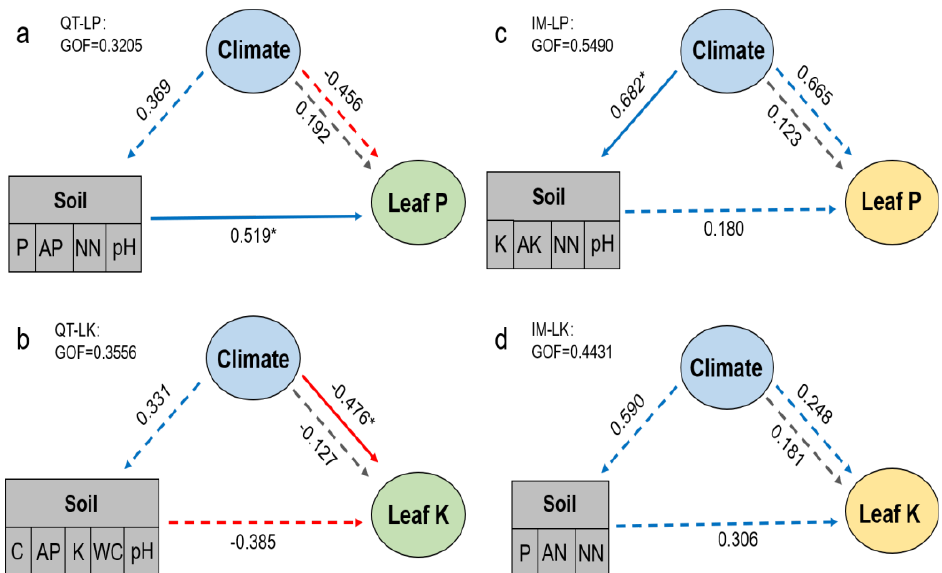
Figure 2. Effects of different soil and climatic variables on the leaf P and K of S. chamaejasme in the Qinghai−Tibet Plateau (QT) and Inner Mongolia Plateau (IM) based on partial least squares path modeling. The blue arrows represent positive pathways, the red arrows indicate negative pathways, both are direct effects. The grey arrows show the indirect effects. The standard path coefficients are shown on the arrow. A significant effect is indicated by an * ( p < 0.05). GOF, goodness of fit of the statistical model. ( a , b ) PLS − PM describing the relationships in QT; ( c , d ) PLS − PM describing the relationships in IM.